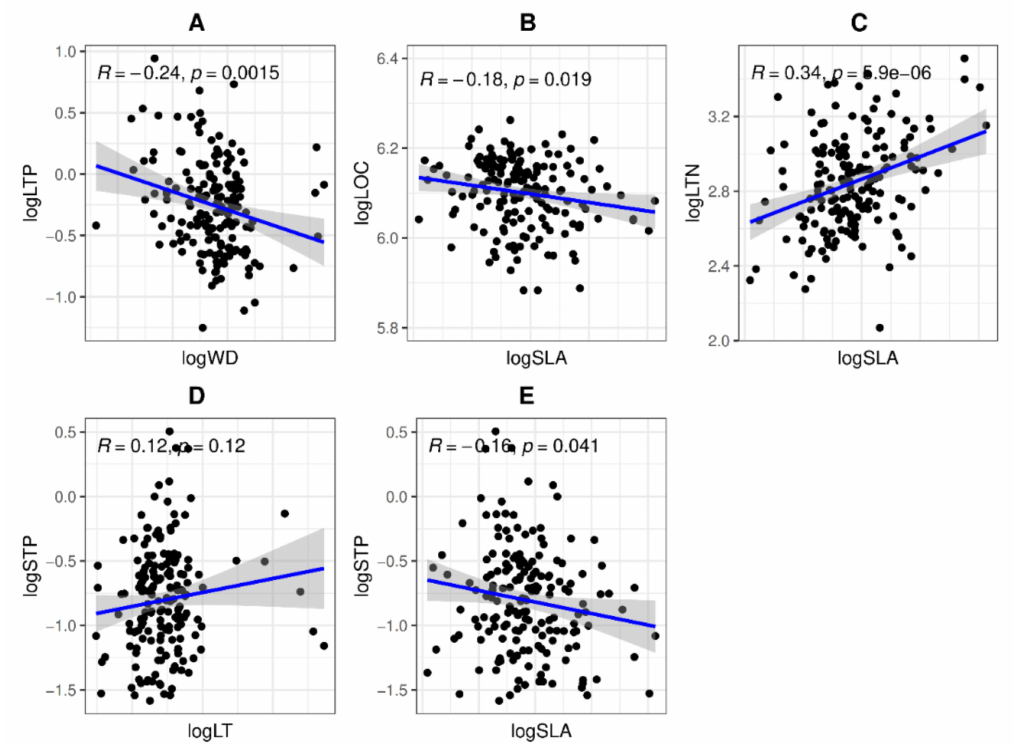
Figure 2. The bivariate relationship among morphological features of woody species’ aboveground vegetative parts in tropical coastal secondary forest. The R and p -values for ( A ) LTP-WD, ( B ) LOC- SLA, ( C ) LTN-SLA, ( D ) STP-LT, and ( E ) STP-SLA were derived from linear regression